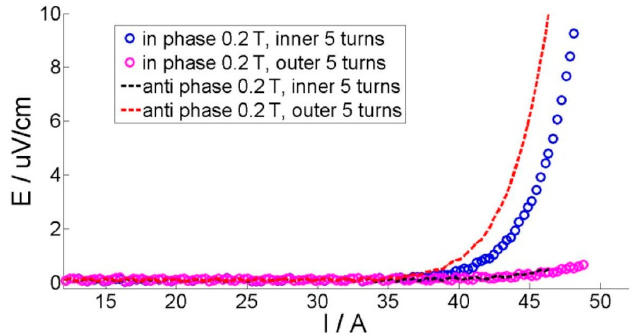
Figure 11. E-I curves of different sections with the SuNAM coil with in-phase and anti-phase 0.2 T magnetic fields.